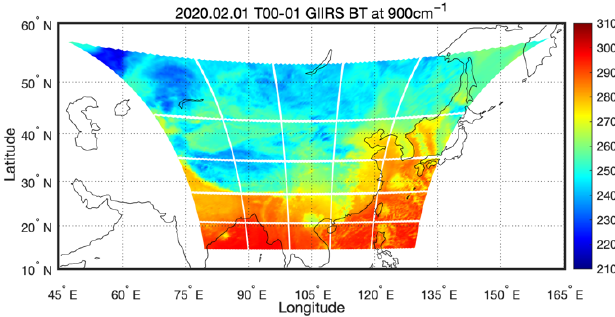
Figure 2. Example of U ‐ Net training sample size.